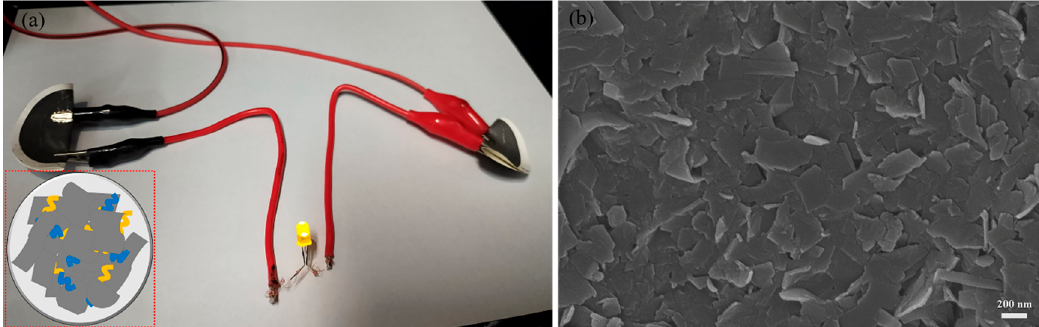
Figure 10. Photograph showing the setup used for electrical conductivity testing of graphene thin films (the inset illustrates the gluing of graphene sheets by SMA molecules at inter-flake junctions) ( a ). SEM micrograph of the graphene film ( b ).